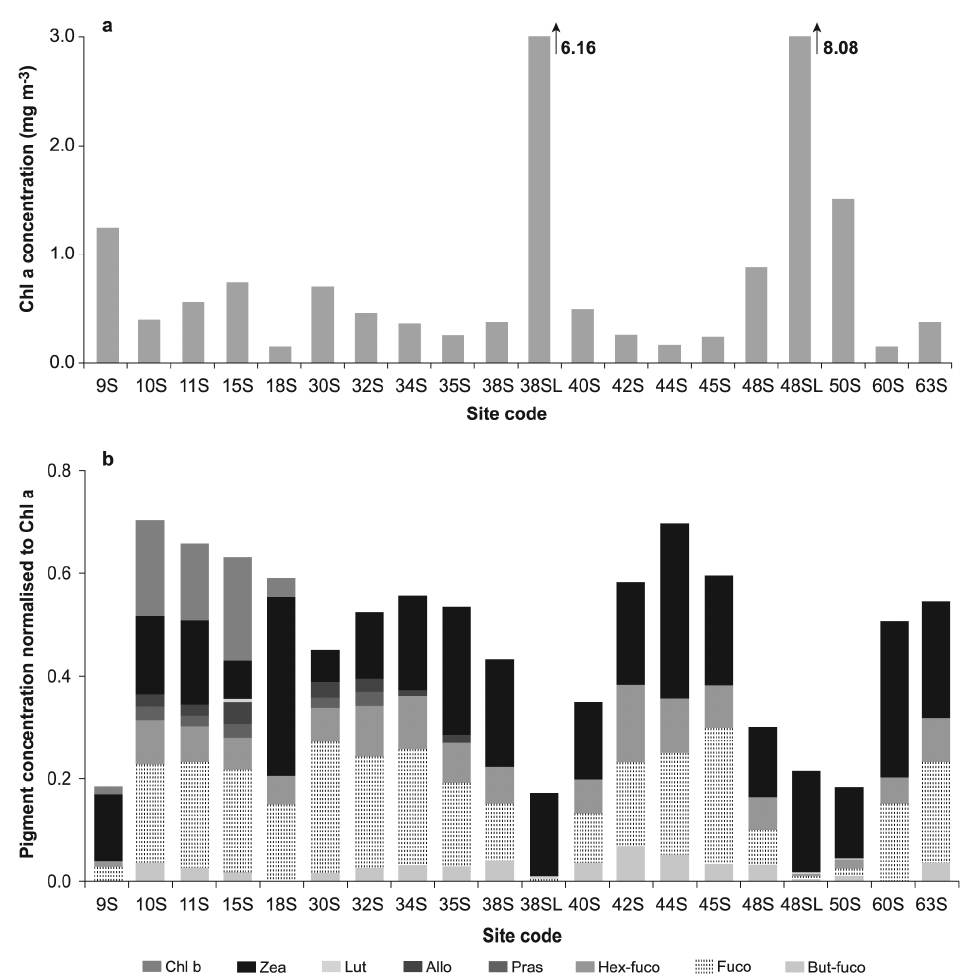
Figure 4. ( a ) chl-a concentration for the surface and near-surface layer samples collected at the sites sampled in Keppel Bay; ( b ) The concentration of marker pigments normalised to chl-a indicating the phytoplankton composition in the surface and near-surface layer samples collected at the sites sampled in Keppel Bay.